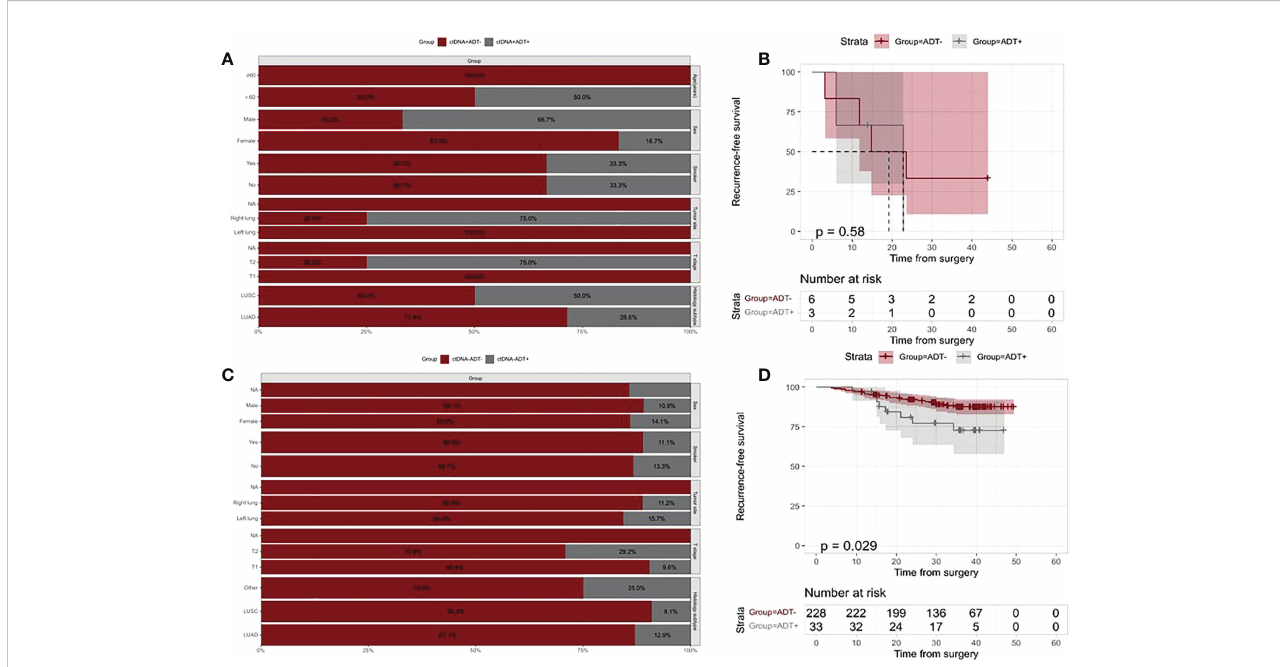
FIGURE 4 Kaplan – Meier analysis of recurrence-free survival according to ADT and postoperative ctDNA status. (A) The distribution of clinicopathologic characteristics for patients who received vs patients who did not receive ADT in the ctDNA-positive group. (B) Kaplan-Meier curve showing RFS strati fi ed by ADT in the ctDNA-positive group. (C) The distribution of clinicopathologic characteristics for patients who received vs patients who did not receive ADT in the ctDNA-negative group. (D) Kaplan-Meier curve showing RFS strati fi ed by ADT in the ctDNA-negative